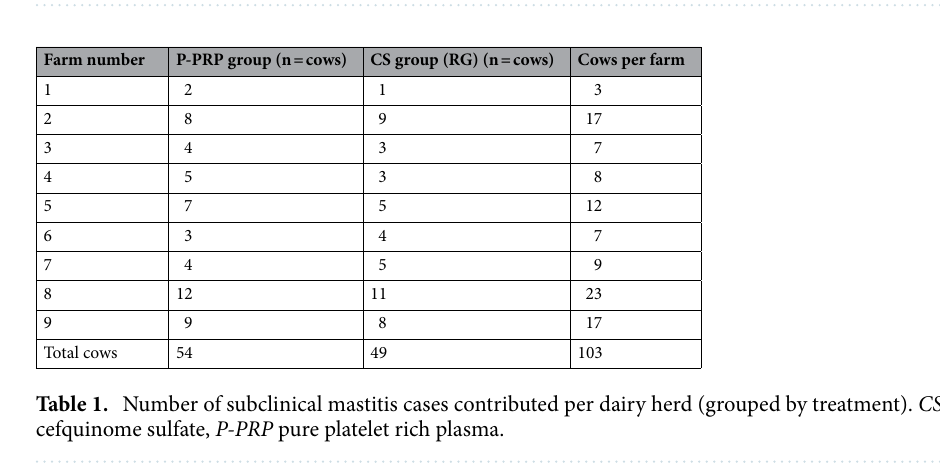
Figure 2. Mean and 95% confidence interval of the concentration (pg/mL) of ( A ) transforming growth factor beta 1 (TGF-β 1 ), ( B ) platelet-derived growth factor BB (PDGF-BB), ( C ) platelet factor 4 (PF4), and ( D ) complement C3 (C3) in hemoderivatives. Different letters represent significant differences (at P < 0.05) for each independent protein between hemoderivatives. PL platelet lysate, PRG pure platelet-rich gel supernatant.